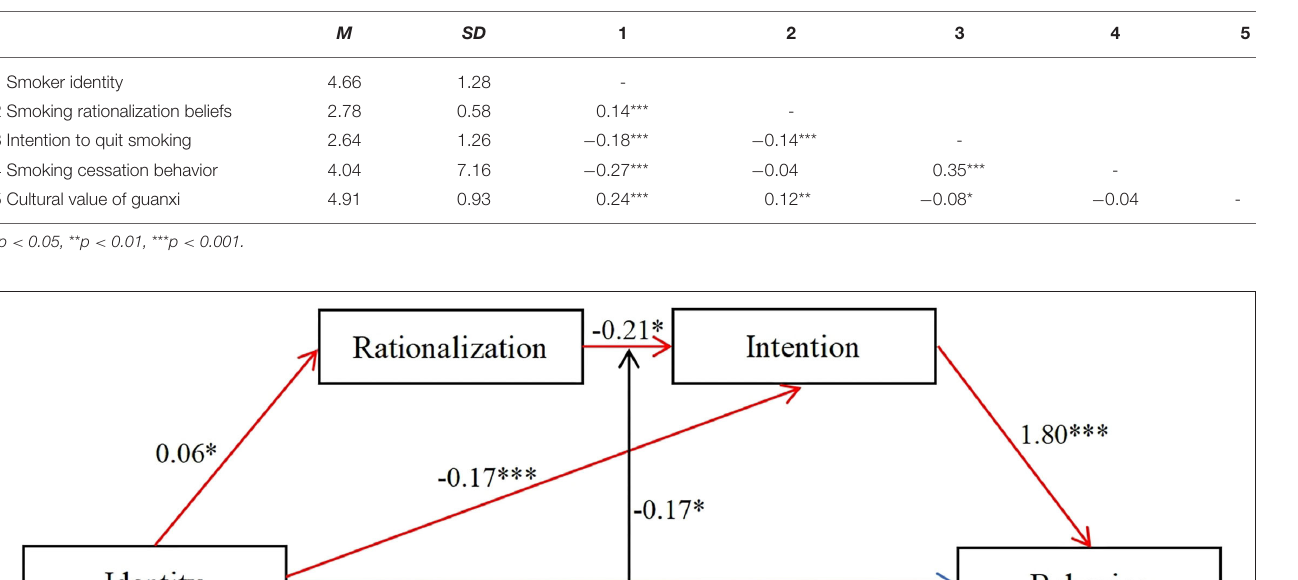
TABLE 2 | Means, standard deviations and partial correlations among variables.